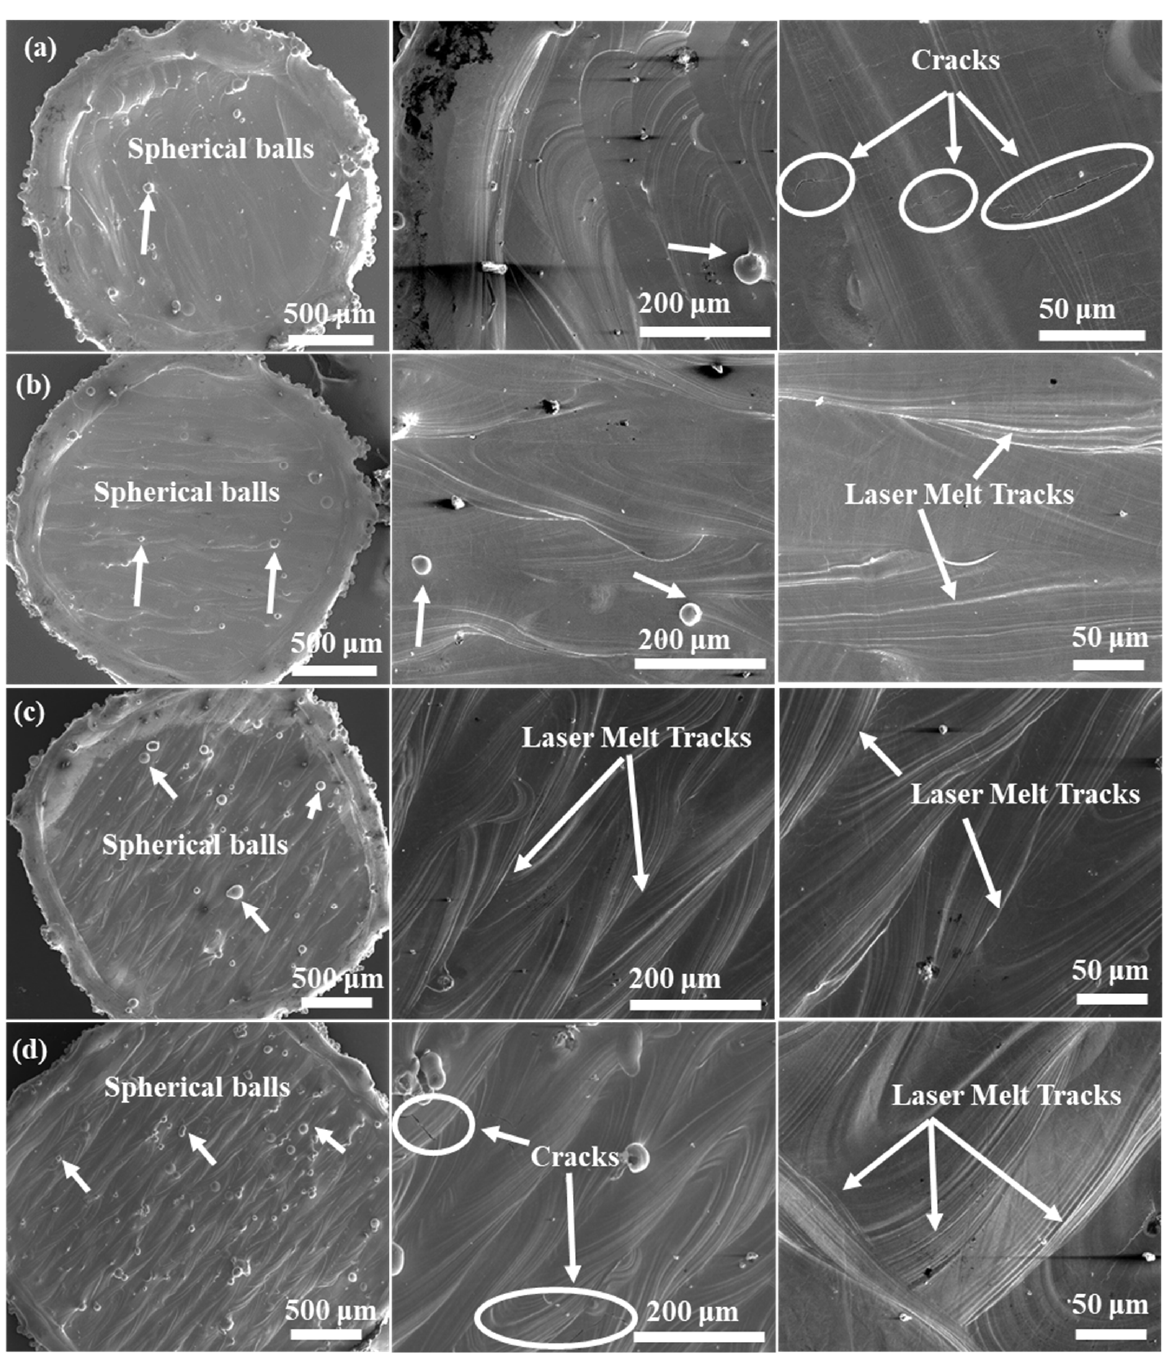
Figure 5. SEM images showing macroscopic features of LPBF fabricated primitive lattice structures with varying relative densities ( a ) RD30, ( b ) RD40, ( c ) RD50, and ( d ) RD60.